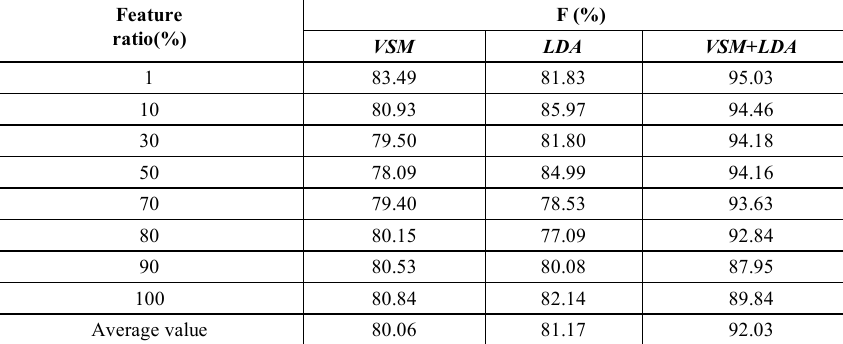
Table 1. The results of the three different